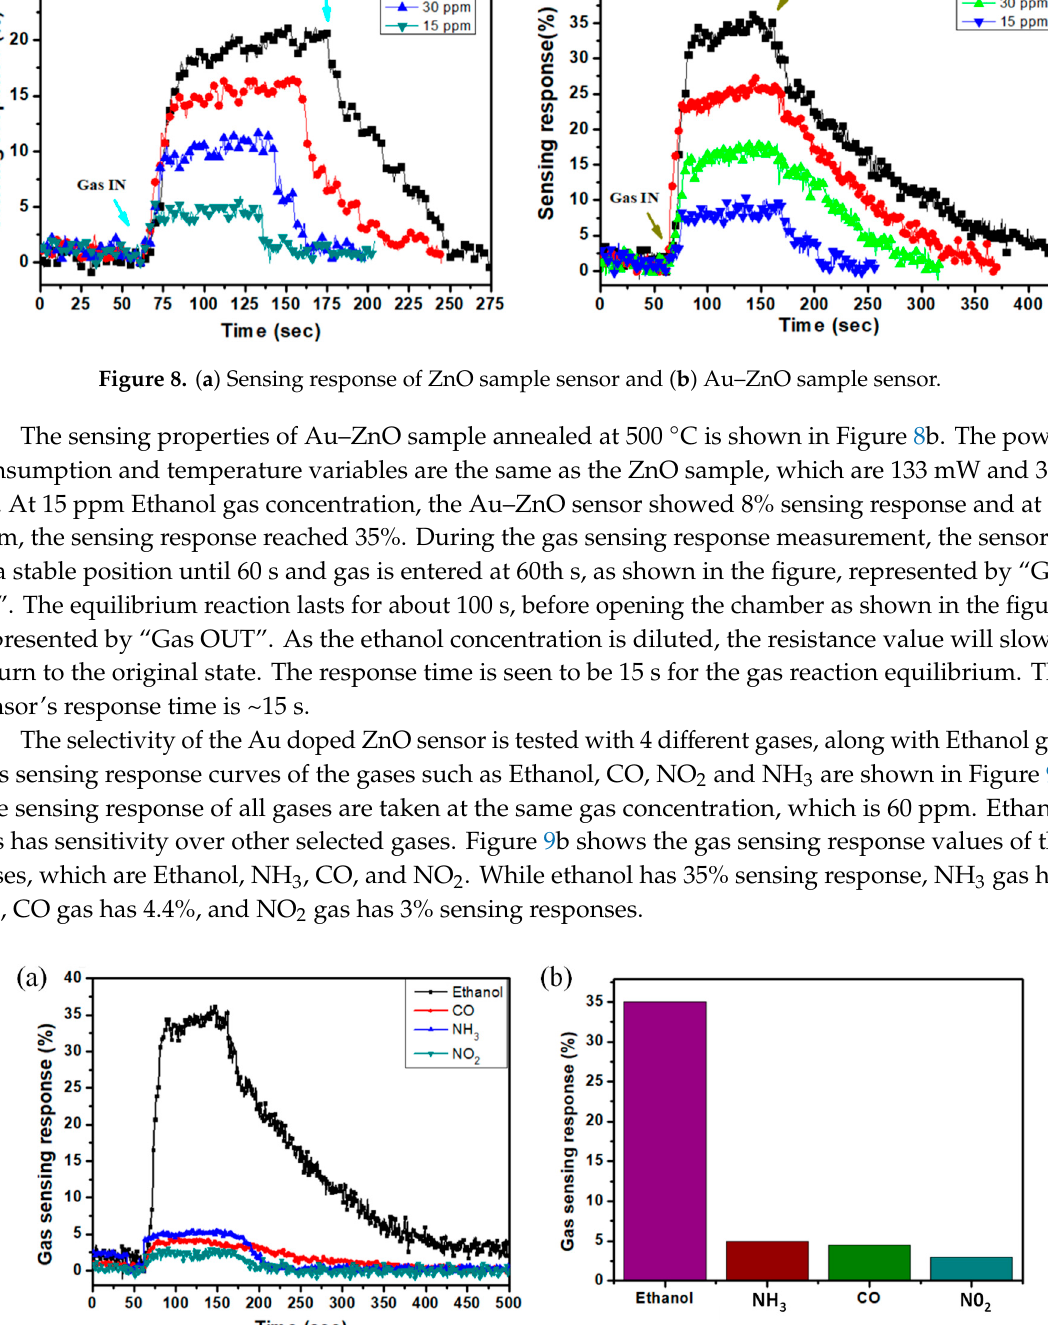
Figure 10. Gas concentration vs. sensing response graph. 3.1. Gas Sensing Mechanism The sensing mechanism for the metal oxide semiconductors occurs due to the change in the resistance which happens due to the interaction of gas molecules and sensing material. ZnO is an n-type semiconductor which contains free electrons, and when the ZnO is treated with Au doping, free electrons from Au are released into the ZnO structure and the number of free electrons will be